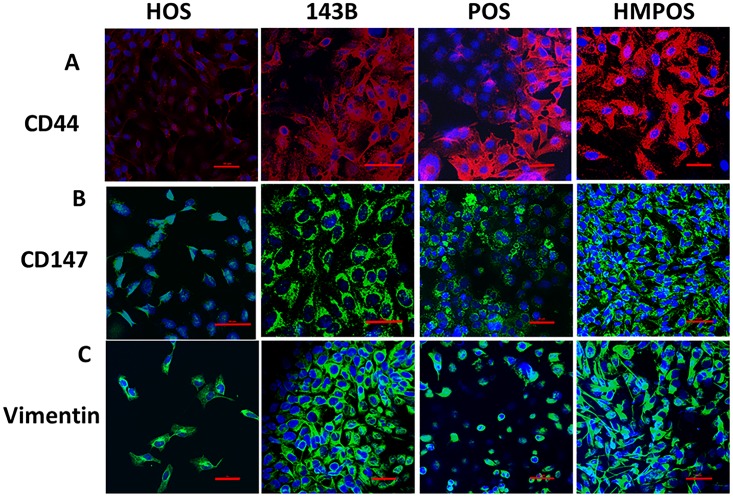
Confocal microscopy images showing the expression of (A) CD44, (B) CD147 and (C) Vimentin.HOS and POS are the non- metastatic human and canine cell lines and 143B and HMPOS are the metastatic human and canine cell lines respectively. Blue staining of nuclei with DAPI and red staining of CD44 with phycoerythrin secondary and green staining of Alexa Fluor 488 for CD147 and vimentin. Red bar in each section corresponds to 50 μm. Details of settings and quantification are indicated in S1 File.